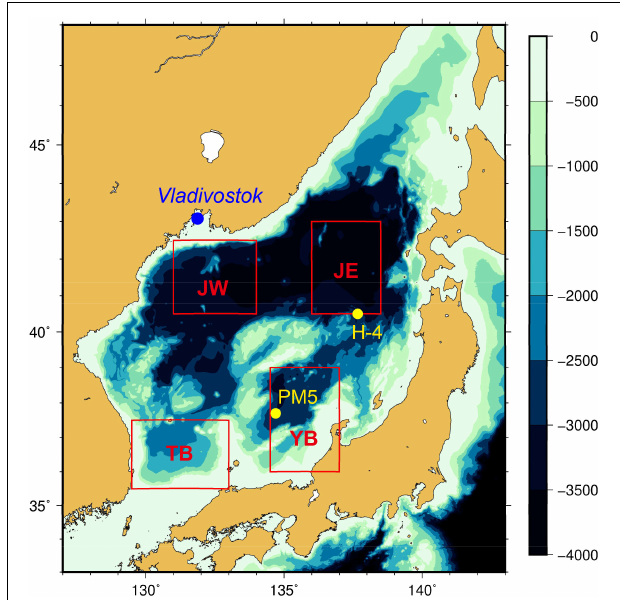
FIGURE 1 | Bottom topography of the Japan Sea. Red squares labeled JW, JE, YB, and TB indicate the areas for the Argo data analysis representing the western Japan, eastern Japan, Yamato, and Tsushima Basins, respectively. Two yellow circles labeled H-4 and PM5 show the long-term hydrographic stations by the JMA. The location of Vladivostok is indicated by a blue